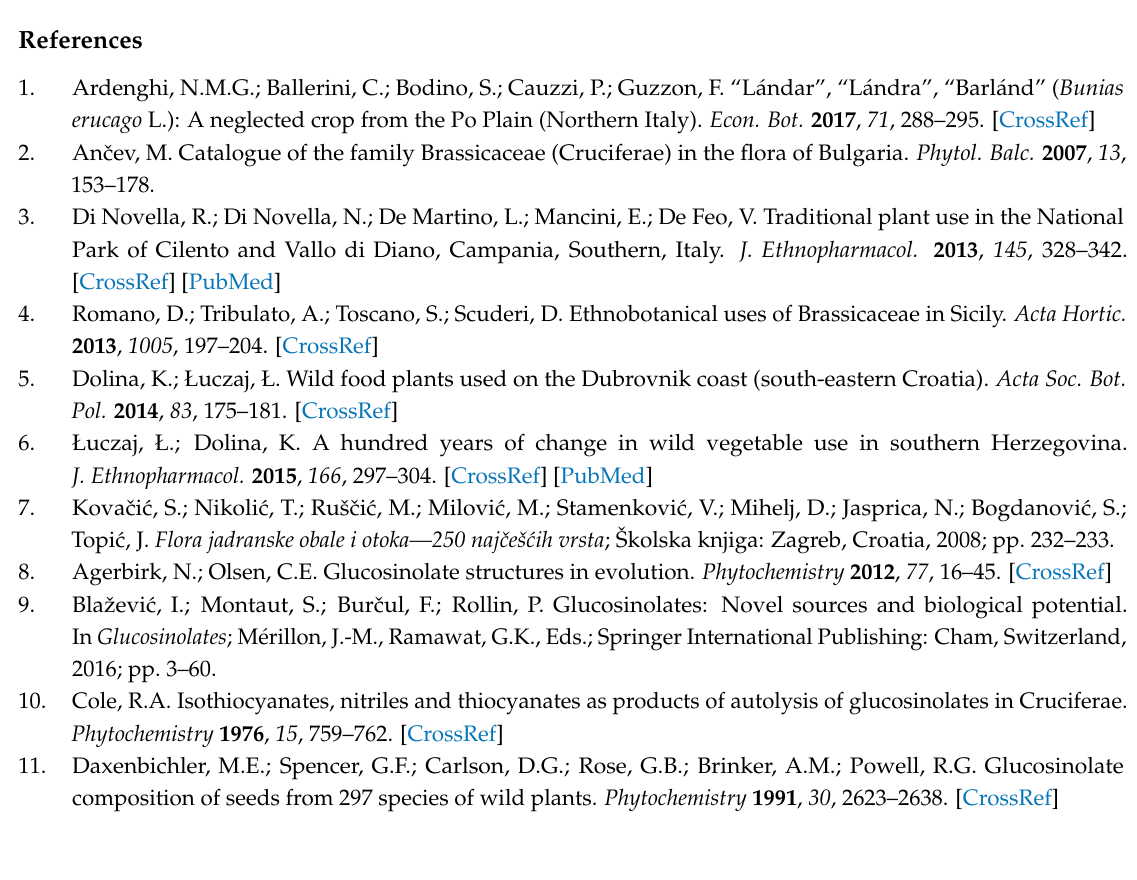
Supplementary Materials: The following are available online, Figure S1: HPLC-PDA chromatograms of the desulfoglucosinolates isolated from flowers of Bunias erucago L.: 1 —gluconapin, 2 —glucoraphasatin, Figure S2: HPLC-PDA chromatograms of the desulfoglucosinolates isolated from leaves and stems of Bunias erucago L.: 1 —gluconapin, 3 —glucoraphenin, 5 —glucoraphanin, 6 —glucotropaeolin, 7 —glucosinalbin. Figure S3: HPLC-PDA chromatograms of the desulfoglucosinolates isolated from roots of Bunias erucago L.: 1